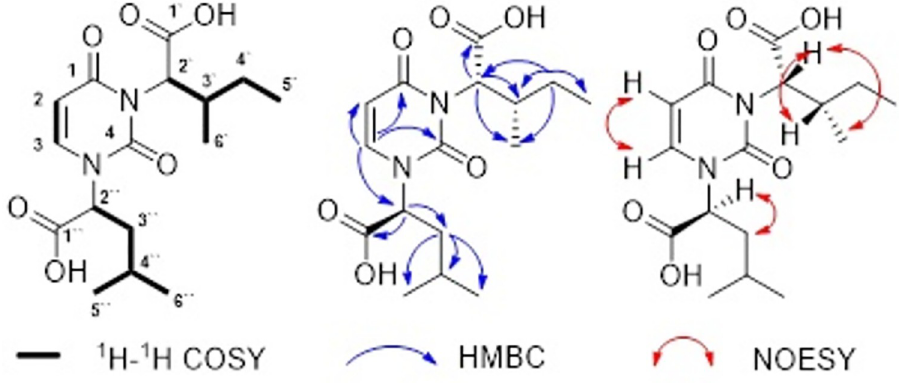
Fig 2. Structure, key 1H-1H COSY (bold lines), HMBC (blue arrows) and NOESY (red arrows) correlations of petromyzonacil (1).